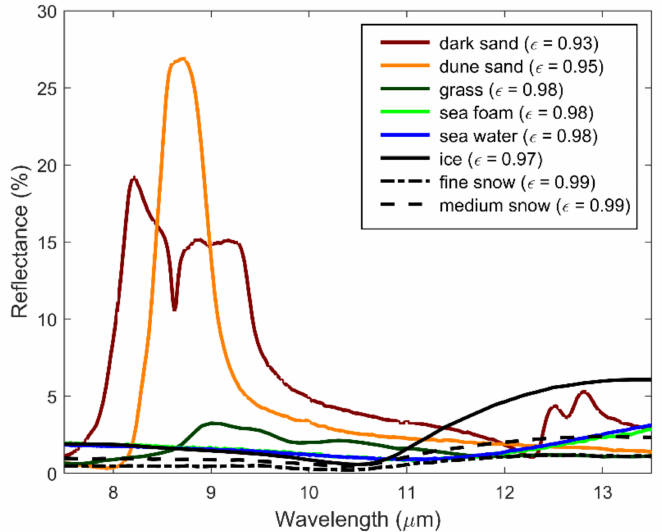
Figure 7. Spectral reflectance from 7.5–13.5 µ m of brown to dark brown sand, white gypsum dune sand, green rye grass, seafoam, seawater, ice (water), medium granular snow, and fine granular snow from the ECOSTRESS spectral library [38–40]. Mean ε is shown in the